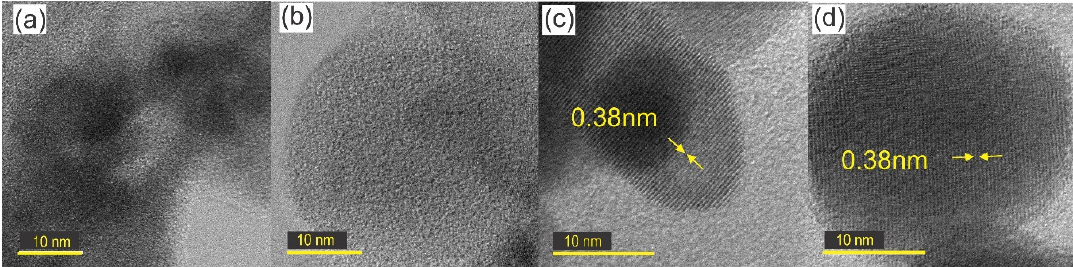
Figure 7. Interplanar distance of sample s10m ( a ) as-synthesized; annealed at: ( b ) 100 °C, ( c ) 300 °C, ( d ) 500 °C.